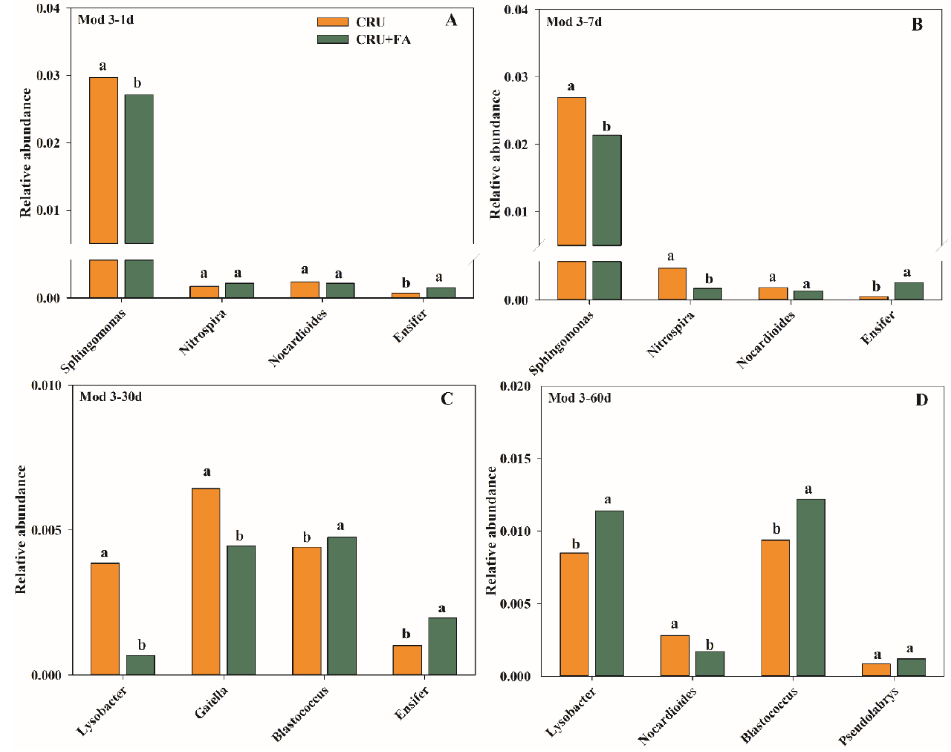
Figure 8. Significant difference potential genera of Mod 3 associated with nitrogen cycle in different incubation days: 1 d ( A ), 7 d ( B ), 30 d ( C ) and 60 d ( D ). Within each graph, means followed with the